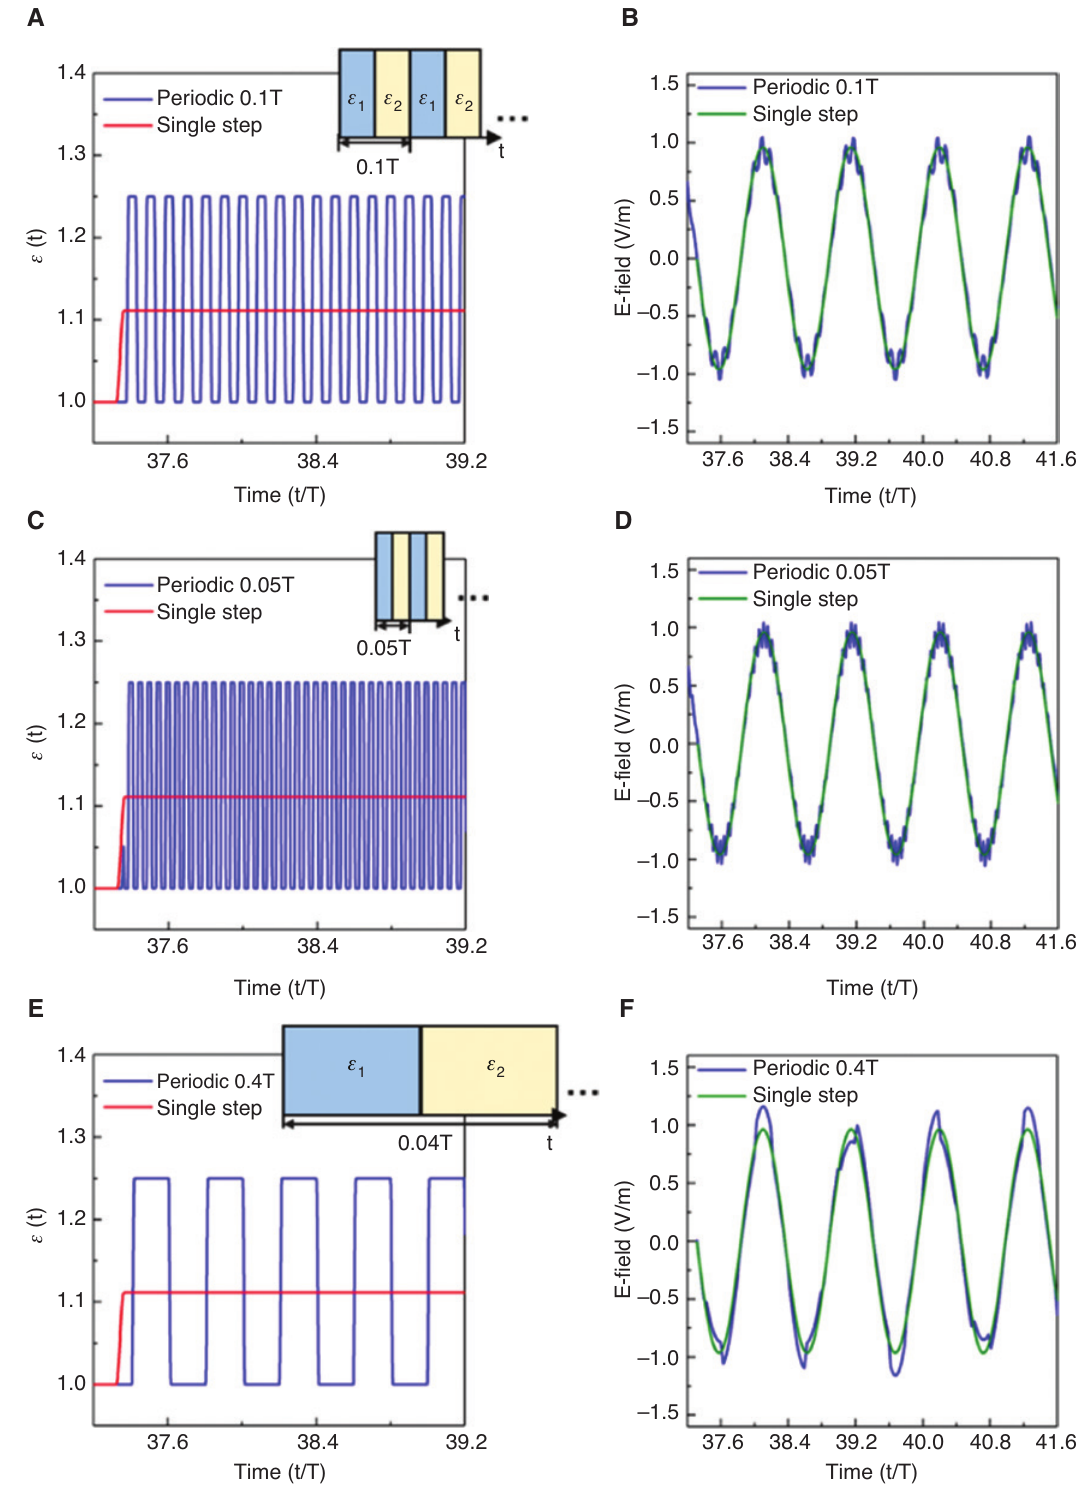
and ε ) and a single step of ε (t) using Eq. (2). 1 2 = 1.111 (red lines) and a temporally periodic ε (t) changing from eff